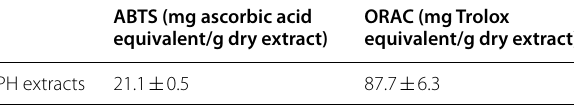
Table 2 Antioxidant activity of the protein